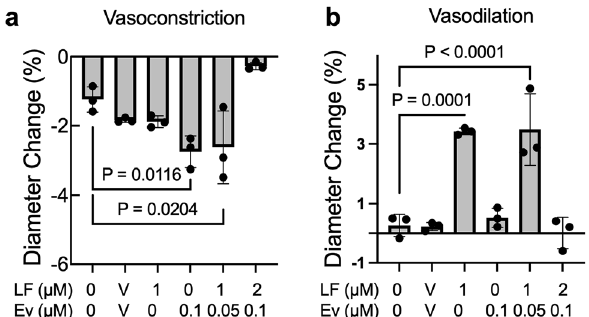
Figure 4. Lonafarnib and Everolimus treatment improves HGPS TEBV vasoactivity. HGPS 167 CL2 TEBVs were matured for 3 weeks, treated with Lonafarnib (LF) and Everolimus (Ev) for 1 week, then exposed to 1 µM phenylephrine followed by 1 µM acetylcholine for 5 min each and diameter change measured. Data presented as mean ± SD. N = 3 experiments per group. Results are compared to the reference condition without Lonafarnib and Everolimus.